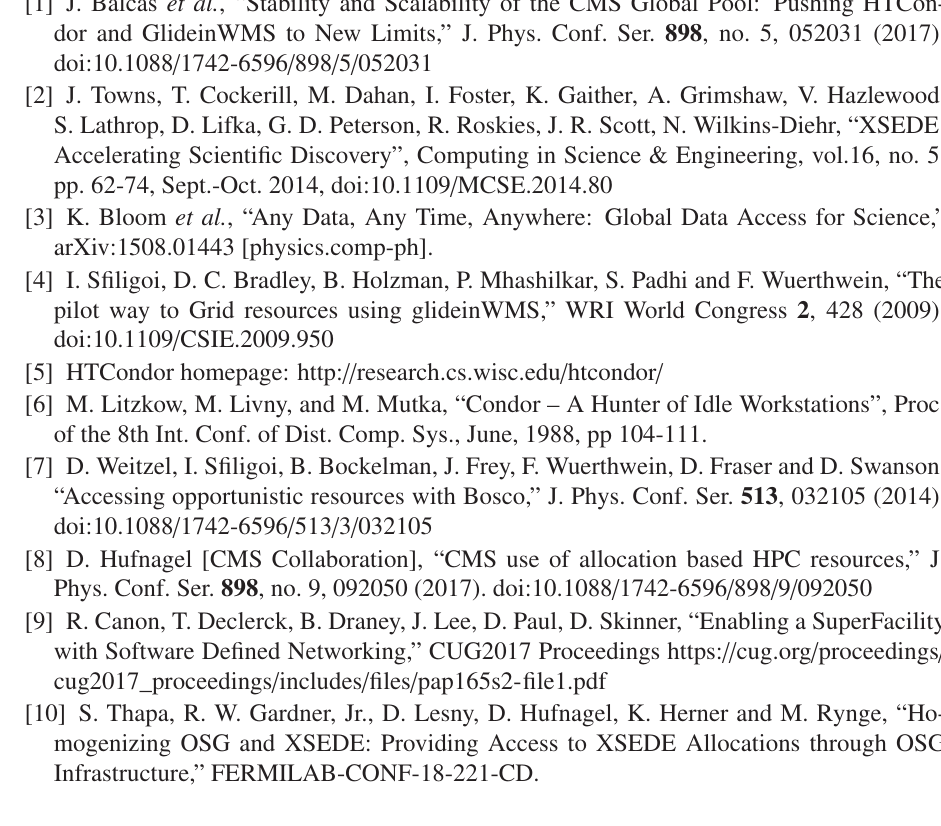
Figure 4. Cores in running CMS jobs at NERSC